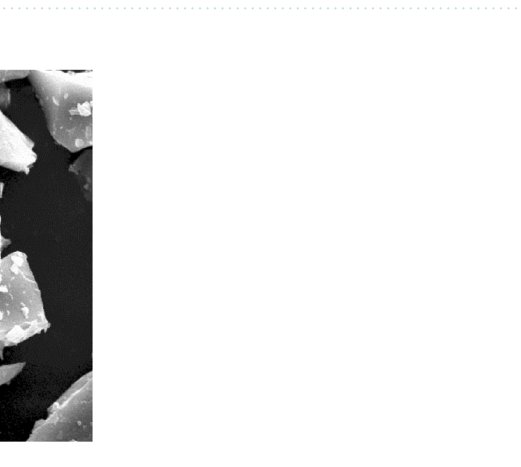
Table 1. Chemical composition (by % weight) of the original LFS.